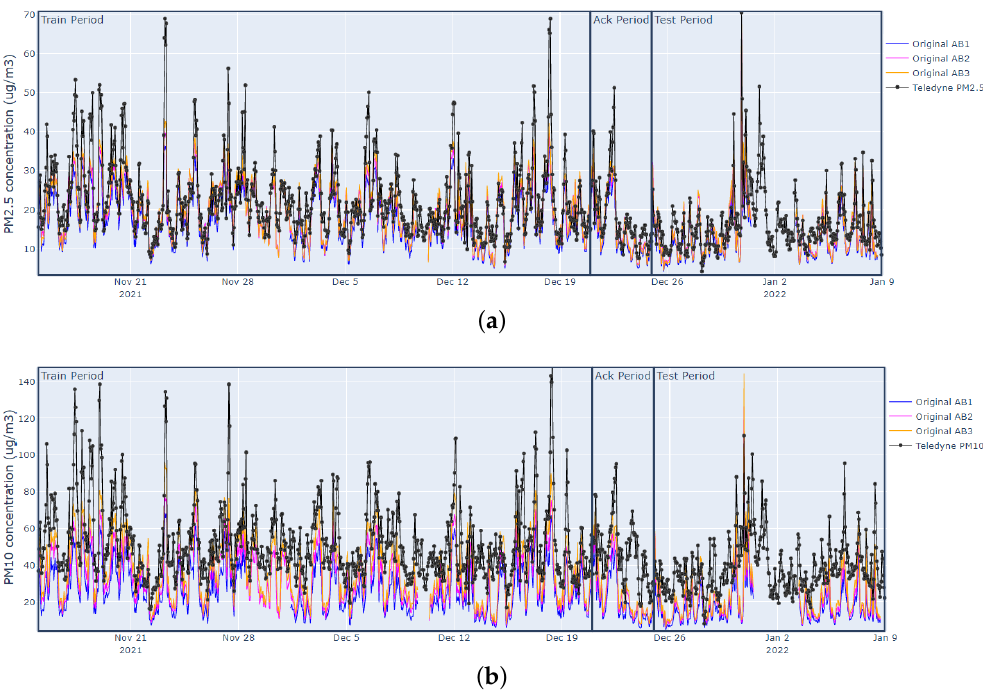
Figure 5. Plots of PM 2.5 and PM 10 hourly data collected by the AirBeam sensors and the reference sensor (Teledyne) during 15 November 2021 to 8 January 2021: ( a ) hourly PM 2.5 series measured by the AirBeam sensors; ( b ) hourly PM 10 series measured by the AirBeam